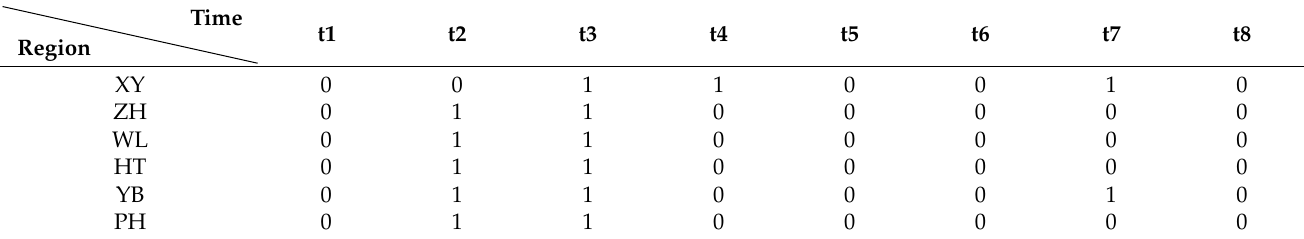
Table 1. Risk levels by district in ZG